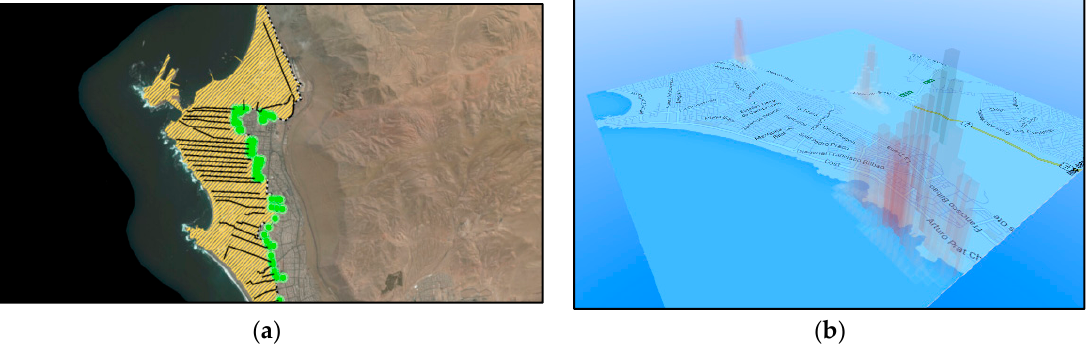
Figure 6. ( a ) Inundation areas, evacuation roads, and safe places at Iquique. ( b ) Inundation areas, evacuation roads, and safe places at